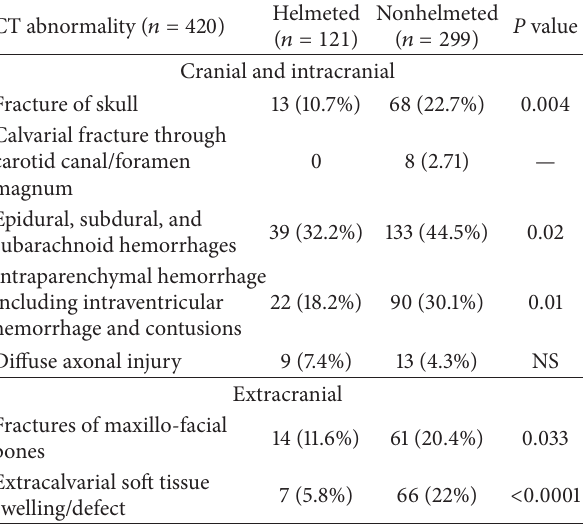
Table 7: CT abnormalities by helmet